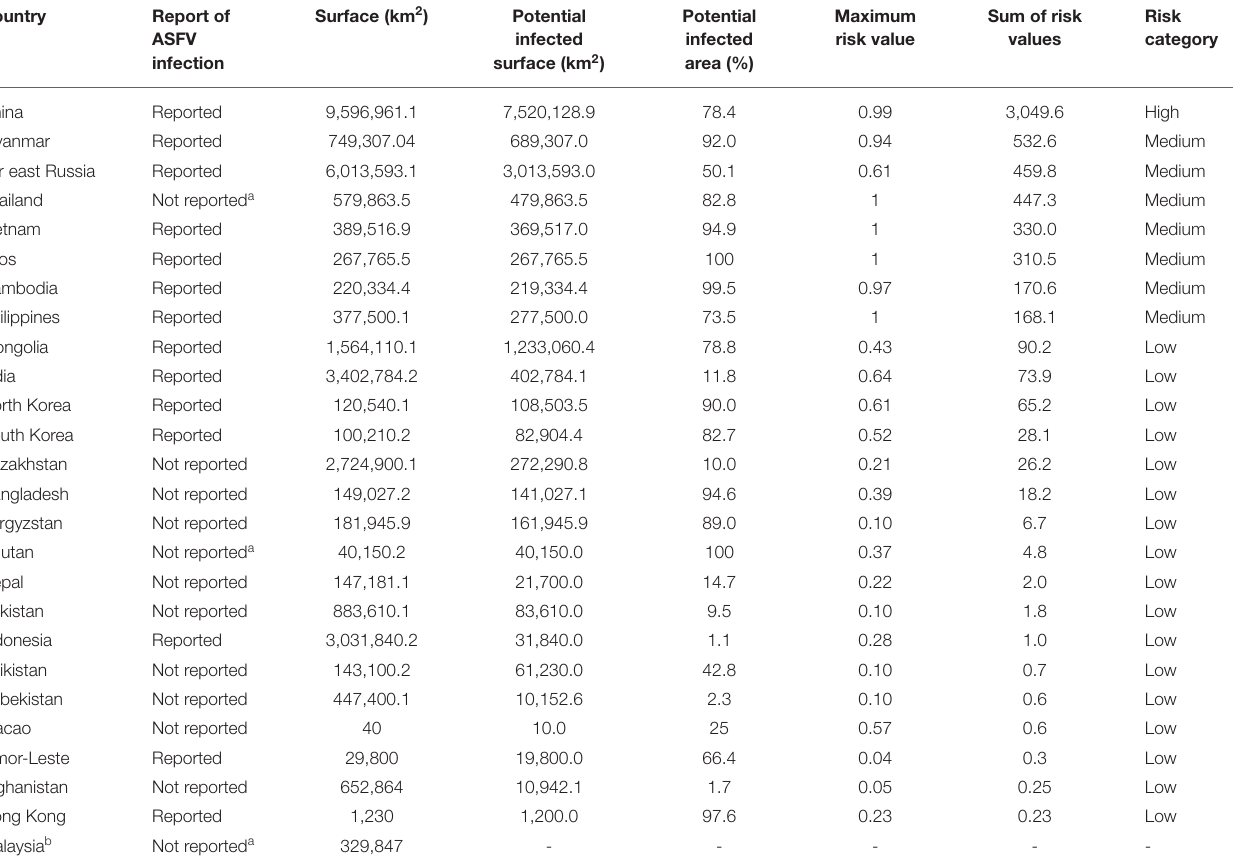
The risk classification is shown in three categories: high, medium, and low. Asian countries not included in this table have no results and should be considered as “No risk of AFS natural spread due to wild boar to date”. a Countries that reported ASFV infection after the period of study. b Although Malaysia was included in the study area, Malaysia did not show risk in our model. The introduction of ASF in Malaysia by wild boar movements is unlikely based on our available